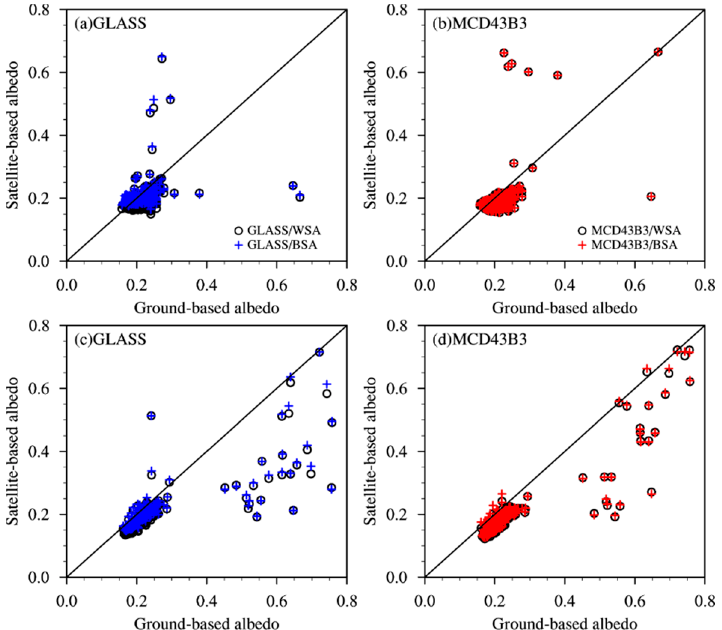
Figure 10. Scatter plots of the 8-day average albedo of ground-based observation and surface albedo products of ( a ) and ( c ) GLASS and ( b ) and ( d ) MCD43B3 at Maqu and Maduo sites, respectively.